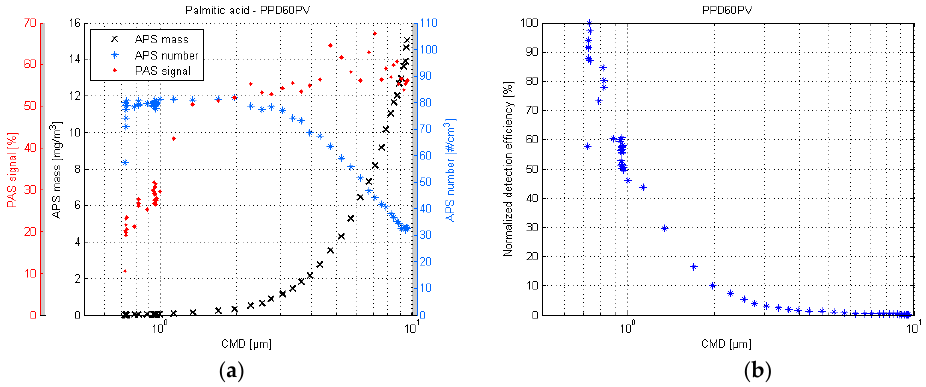
Figure 7. PPD60PV response plot of the palmitic acid test ( a ) and the respective normalized detection efficiency scatter plot ( b ).